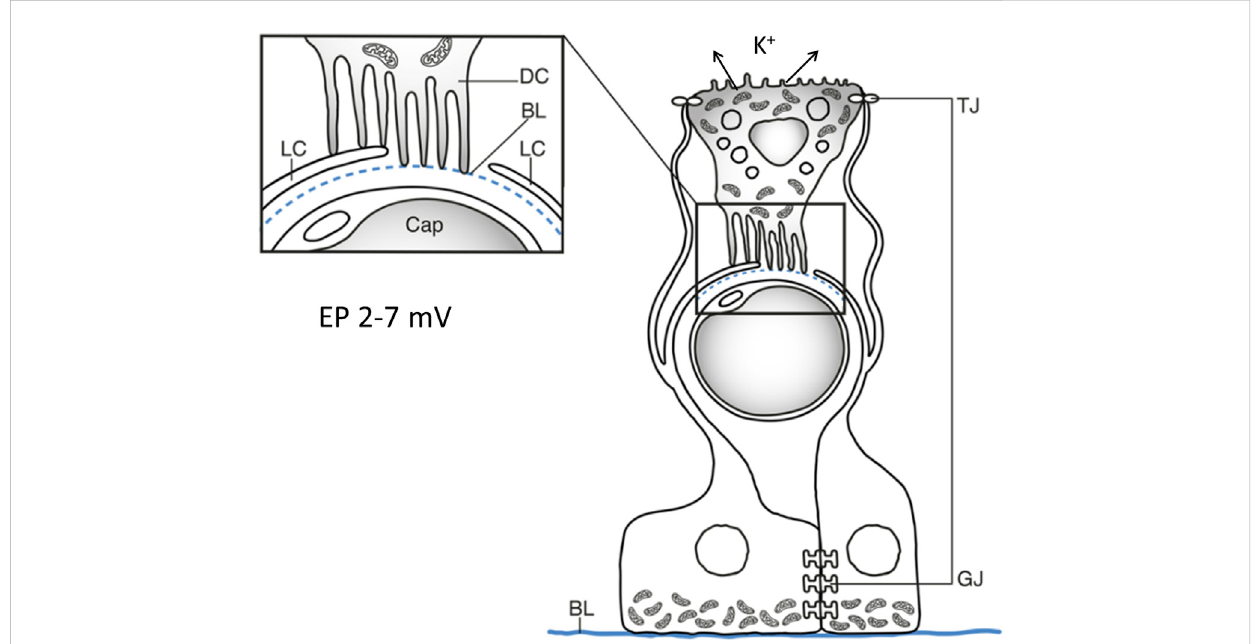
FIGURE 11 Graphic illustration showing relationship between the SV cells and intra-epithelial capillaries (Cap) and hypothetical representation of endolymph secretion and EP formation in the crocodilian stria vascularis (Crocodylus rhombifer). The dark cell (DC) projections interact with the light cell as well as the pericapillary basal lamina (BL). The light cells (LC) are intercellularly coupled through gap junctions (GJ) allowing ions to be mediated. The light cells form dilated extra-cellular spaces by branches reaching the apical region of the dark cells where they form tight junctions (TJ). These spaces could form a unique environment for the exchange and transport of